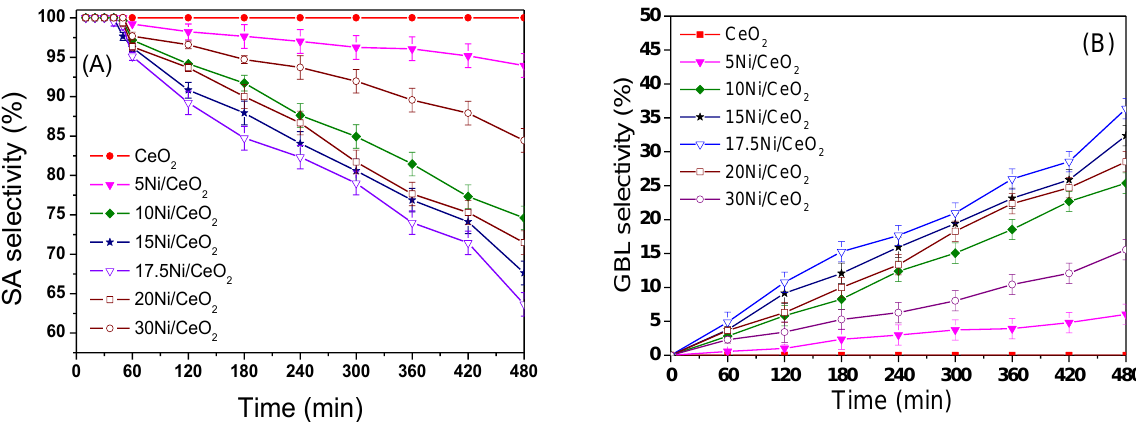
Figure 13A shows the trend of SA selectivity with reaction time on different catalysts. From Figure 13A and B, the selectivity of SA for all xNi/CeO 2 catalysts was around 100% at the initial reaction time of 40 min and then decreased gradually while the selectivity of γ -butyrolactone (GBL) increased gradually. The selectivity of GBL on the 17.5Ni/CeO catalyst was the highest (about 35.7%) after 8 h compared with the other xNi/CeO 2 catalysts. In addition, the selectivity of SA on the CeO 2 support remained at 100% within 8 h of the reaction, indicating that the CeO 2 support had almost no hydrogenation activity for the C=O bond. The above results identify that the metal Ni was the active center for the hydrogenation of SA to GBL and that the content of Ni loading significantly affected the C=O hydrogenation over the catalyst. As for the stability of the xNi/CeO 2 catalysts, it should be noted that all samples showed good stability in the hydrogenation process. After a reaction time of 1 h, the conversion of MA for all xNi/CeO 2 catalysts was close to 100%, and the catalysts kept their high catalytic performance. Furthermore, after five cycles of use, all the catalysts kept their high activity and selectivity, and there was no obvious decrease in either. In addition, the stability of the 17.5Ni/CeO 2 catalyst had no obvious change compared with other catalysts in the MAH process.